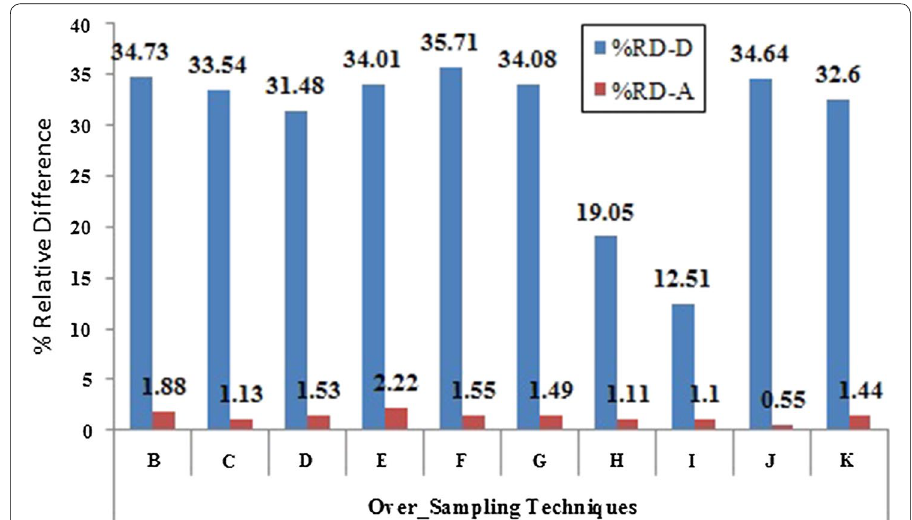
Fig. 6 Comparison of % relative difference in data set instances over AUC values